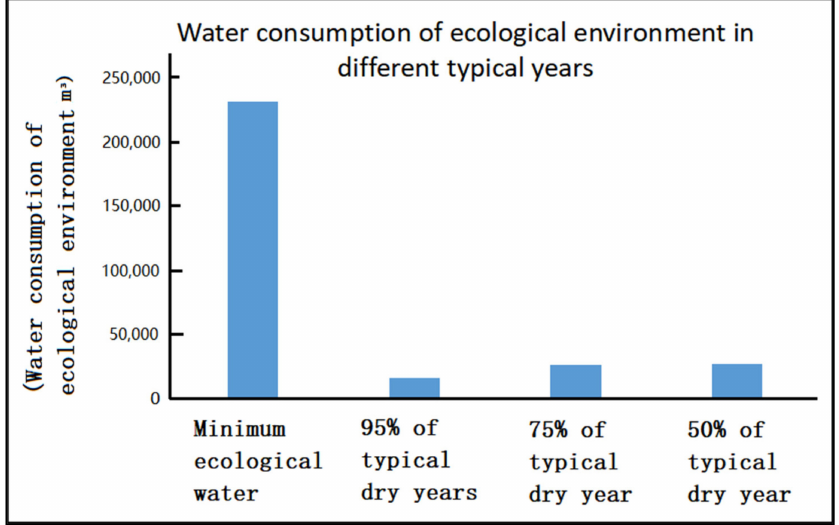
Figure 12. Maximum eco-environmental water consumption in different typical